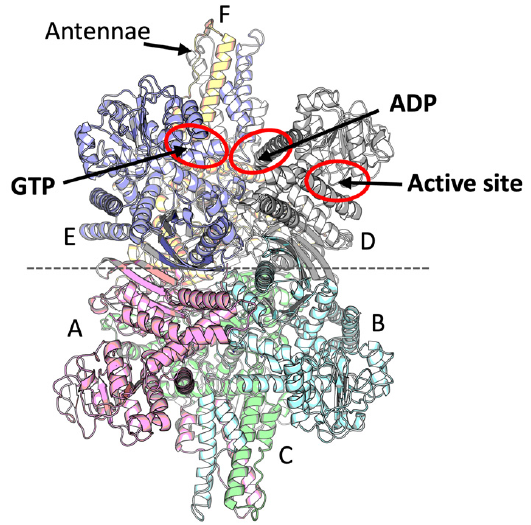
Figure 1. A mammalian GDH model and its ligand binding sites. The six subunits are shown in different colors, while the hexamer is organized as two trimers related by a two-fold axis indicated by a dashed horizontal line. Chains corresponding to 8AR7 and 8AR8 structures are indicated on the graph, showing A, B, C or D, E, F chains to form the two opposite trimers of the GDH hexamer in these models. Two antennae regions are located at the top and bottom of the hexamer, built by three subunits each. Red ovals indicate the active site and allosteric sites for the activator ADP and inhibitor GTP.